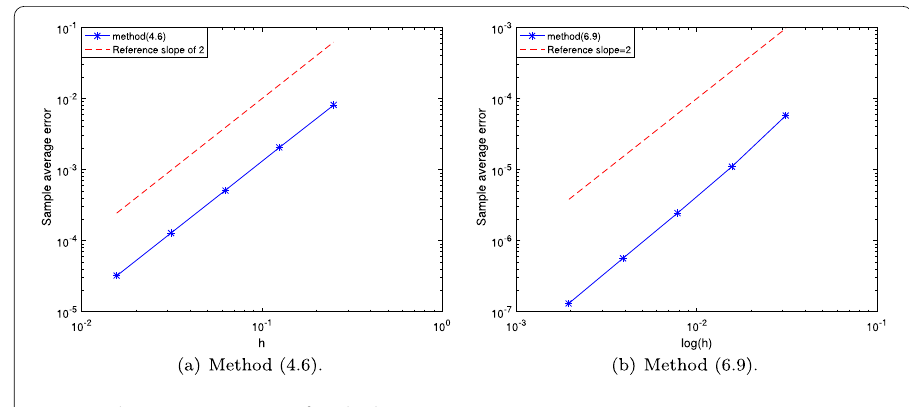
Figure 2 The convergence rates of methods